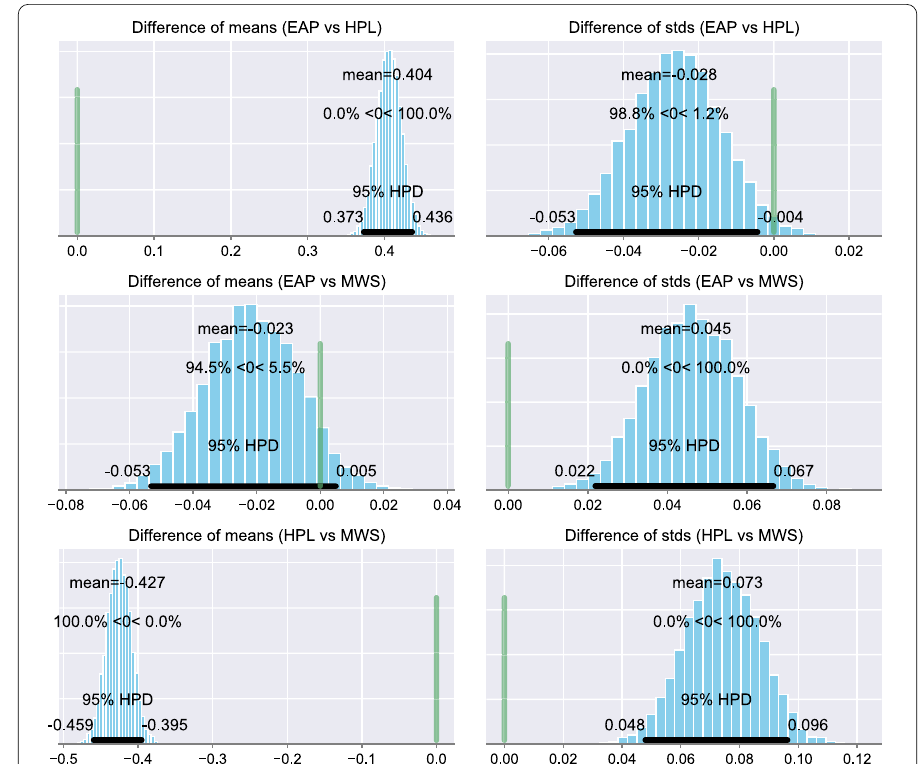
Figure 13 Posterior distributions and 95% credible intervals of differences for log-transformed feature Quantile-Abs-Changes. Left column: difference of means. Right column: difference of standard deviations. Top row: EAP vs HPL. Middle row: EAP vs MWS. Lower row: HPL vs MWS. The 95% credible intervals are shown as black horizontal